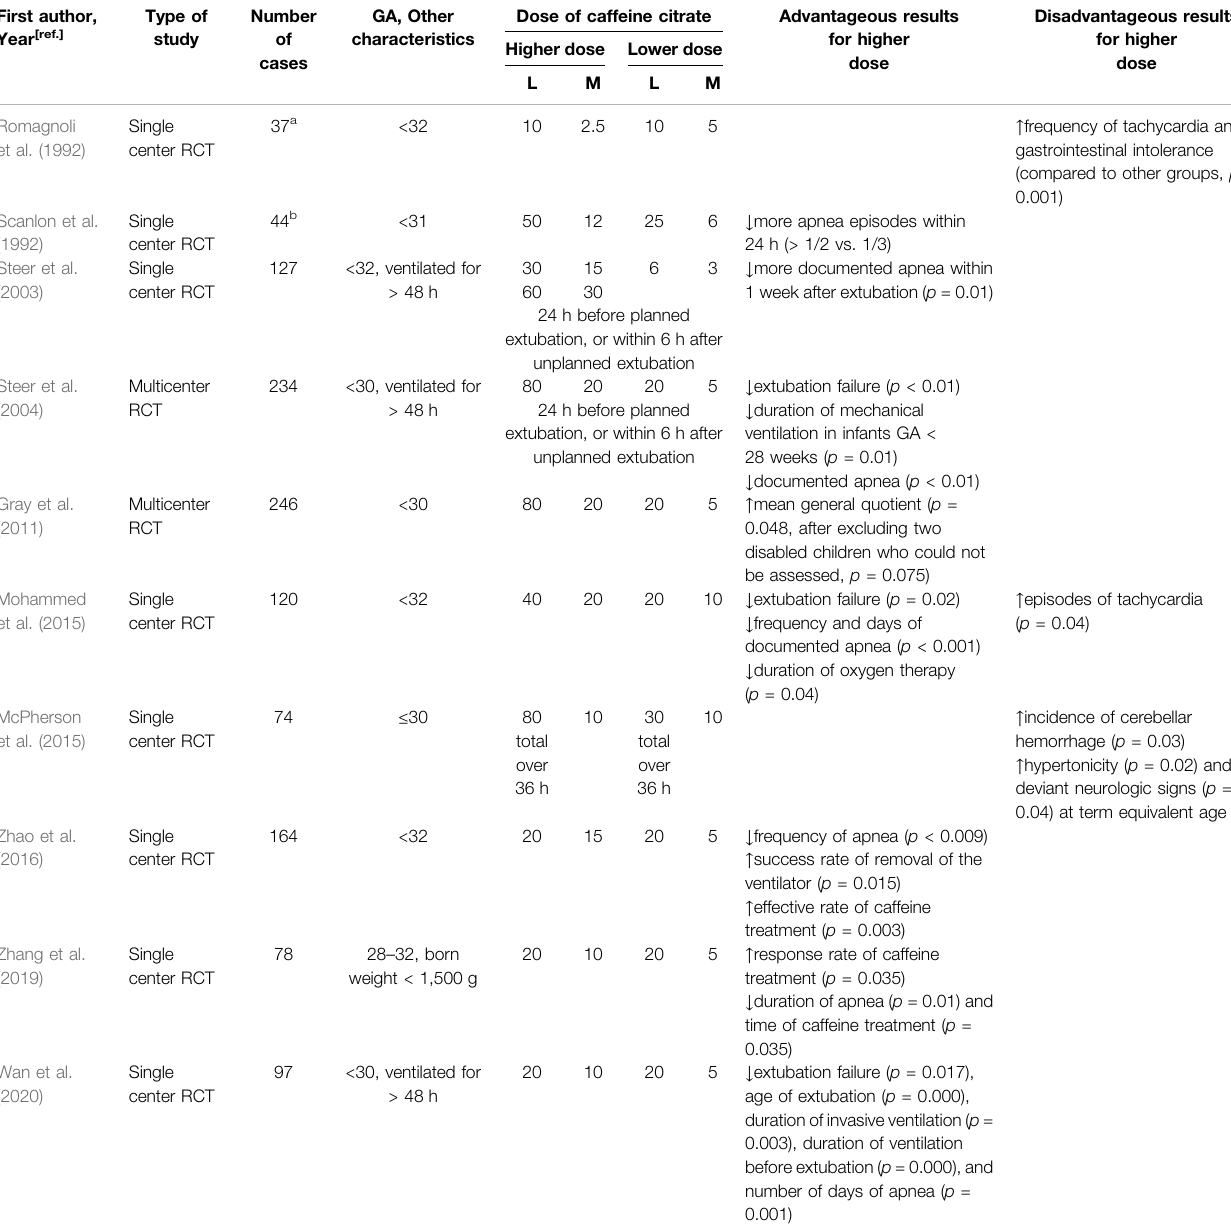
TABLE 4 | Advantageous and Disadvantageous Results for Higher vs. Lower Doses of Caffeine in Randomized Controlled